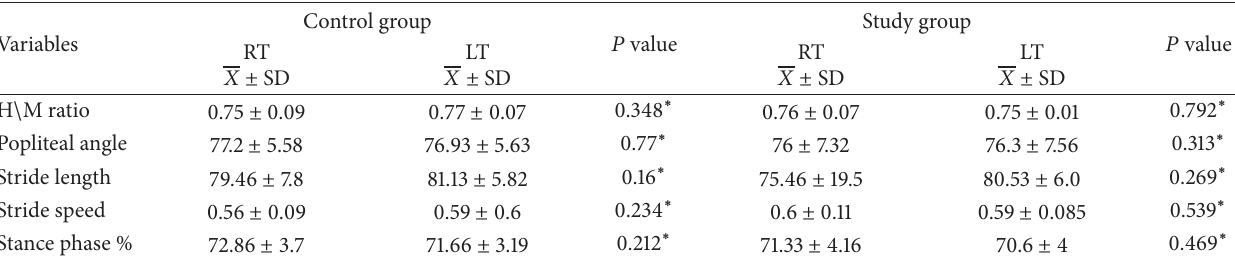
Table 2: Pretreatment comparison between right and left side in each